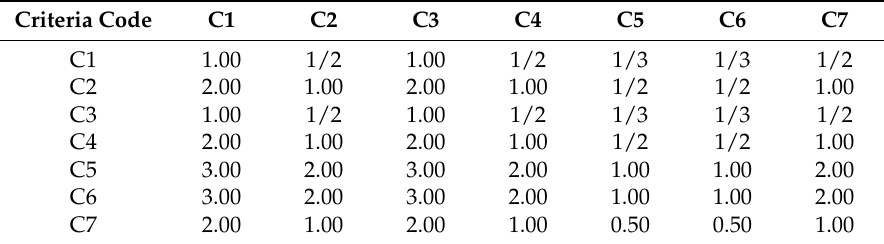
Table 6. Matrix of pair comparison between the criteria in relation with the